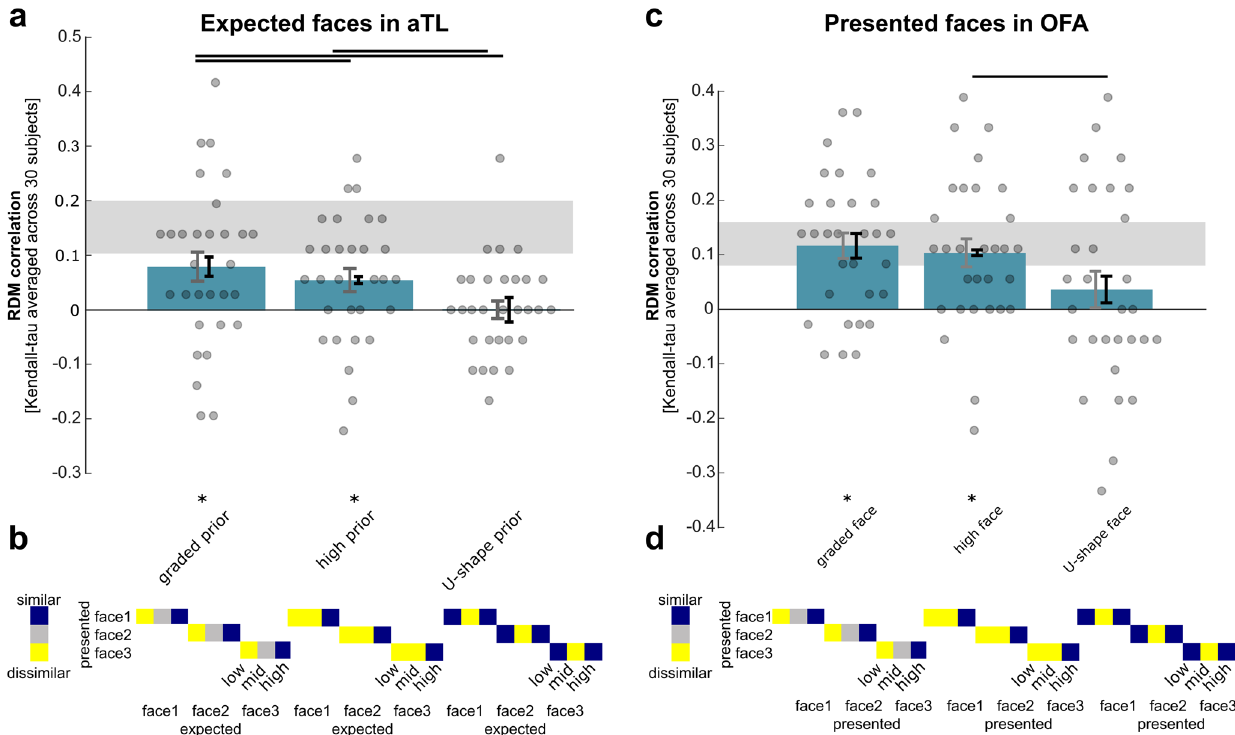
Fig. 4 Multivariate fMRI results. a Representation of expected faces in the anterior temporal lobe face region (aTL). The correlation between the reference representational dissimilarity matrix (RDM) and the hypothesis RDMs was used to measure the performance of each hypothesis RDM. Gray error bars indicate the standard error of the mean, based on the across-subject variation, black error bars indicate the within-subject standard error of the mean 86 , and asterisks indicate signi fi cance with FDR control p < 0.05. The black horizontal lines indicate the pairwise comparisons for which the hypothesis RDMs perform signi fi cantly differently (FDR controlled p < 0.05). The gray horizontal bar shows the noise ceiling, i.e., the upper and lower bound estimates of the maximum performance any model could achieve given the level of noise in the data. b The hypothesis RDMs tested representations of graded expectations, only the high expectation, and a u-shape. The three hypothesis RDMs are presented in performance descending order. c Representation of presented faces in the occipital face area (OFA). d The hypothesis RDMs for testing the representation of presented faces, depending on how much they were expected. Again, the three hypothesis RDMs are presented in performance descending